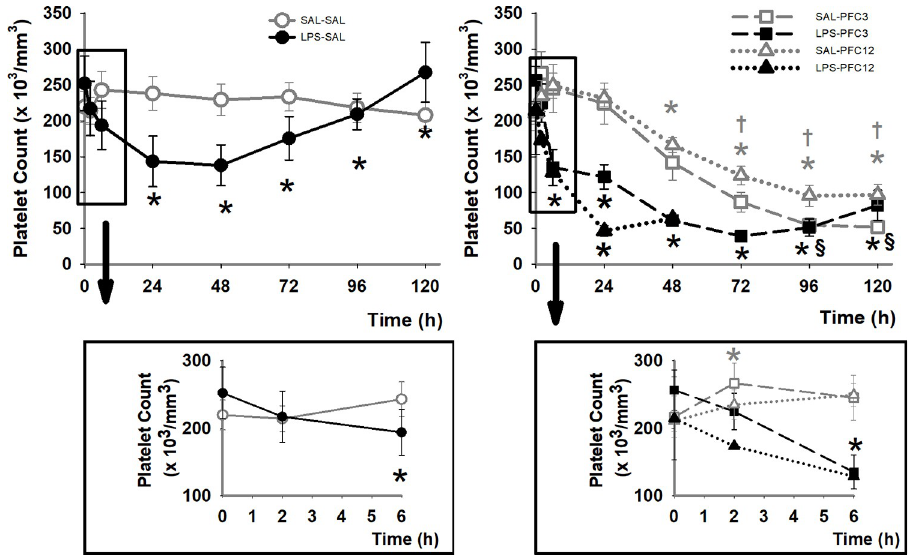
Fig 3. PFC addition exacerbates LPS induced thrombocytopenia. A. Baboon platelet numbers show a transient decrease in response to LPS with recovery by 120 h. B. Infusion of PFC in the presence or absence of LPS results in a persistent decline in PLT count. Upper panels show entire time course. Lower panels show early time points on an expanded scale. Open or closed symbols depict initial infusion conditions with open for saline and closed for LPS. Graphs of initial infusions with saline are in grey. Symbol type depicts second infusion with squares, circles and triangles for saline, PFC3 and PFC12, respectively. Error bars depict SEM. Data that are significantly different, p < 0.05, are shown compared to: baseline, by � ; to SAL-SAL (SAL-PFC groups only), by †; and to LPS-SAL (LPS-PFC groups only), by §. Both treatment group and time show significant differences with an interaction between both treatment group and